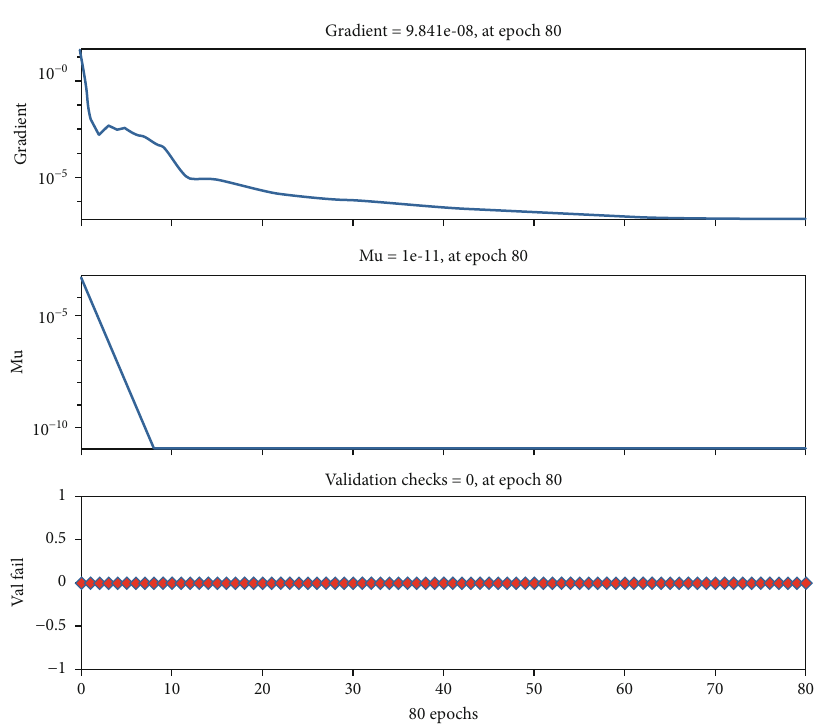
Figure 7: DNN-PV MPPT controller training